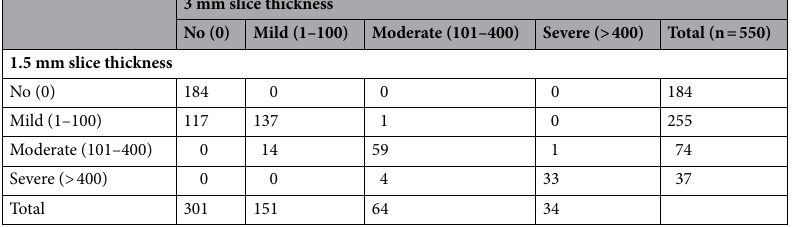
Table 1. Categorical agreement for CAC score between 1.5 mm and 3 mm slice thickness reconstruction. CAC Coronary artery calcium.